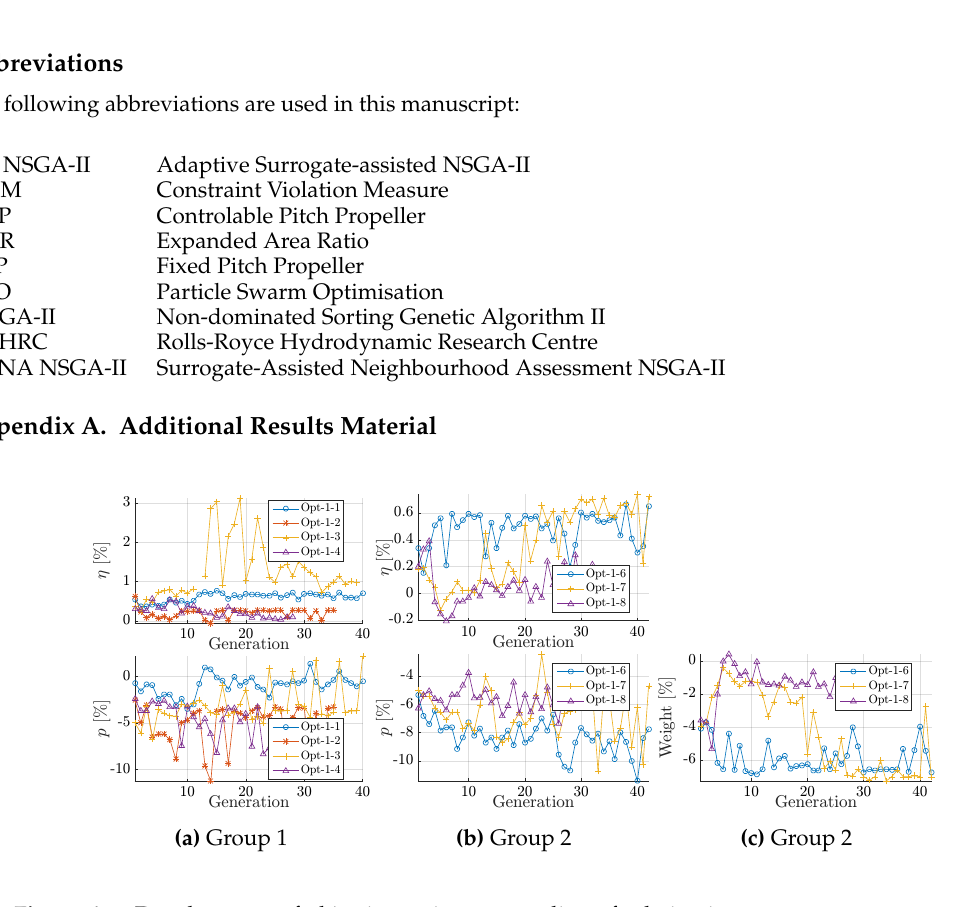
Figure A1. Development of objectives, given as median of relative improvements per generation. ( a ) Group 1; ( b ) Group 2; ( c ) Group 2.